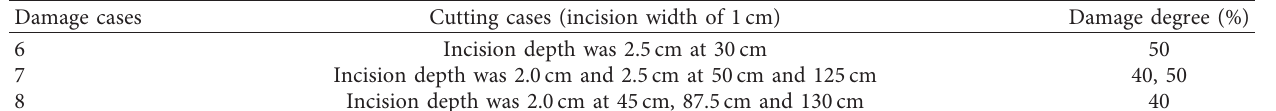
Table 7: Test simulation damage cases.